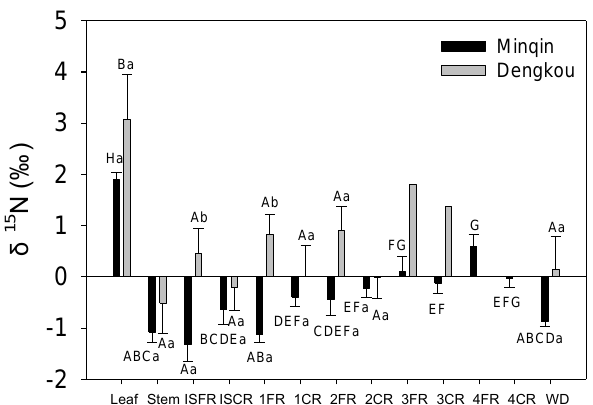
Figure 2. A comparison of δ 15 N among different plant organs of Nitraria tangutorum Bobrov and between the Dengkou and Min- qin study sites. The δ 15 N value shown is averaged for each organ across the nebkhas excavated at the same site (Dengkou or Min- qin). Upper-case letters denote ANOVA results within a study site (i.e., comparing δ 15 N among different organs at the same site) and lower-case letters between the two sites (i.e., comparing δ 15 N of the same organ between the two sites). ISFR and ISCR stand for fine and coarse roots, respectively, in the sands of nebkhas. 1FR, 2FR, 3FR, and 4FR stand for fine roots at 0–20, 20–40, 40–60, and 60–80cm depths, respectively, below the plains on which nebkhas rest. Similarly, 1CR, 2CR, 3CR, and 4CR stand for coarse roots within these depth intervals. Fine and coarse roots are differentiated with a diameter threshold of 2mm. Woody debris (WD) from dead ramets is also included in the figure. No ANOVA results for 3FR and 3CR at the Dengkou site as there was only one nebkha having roots between 40 and 60cm. No roots were found below 60cm at the Dengkou